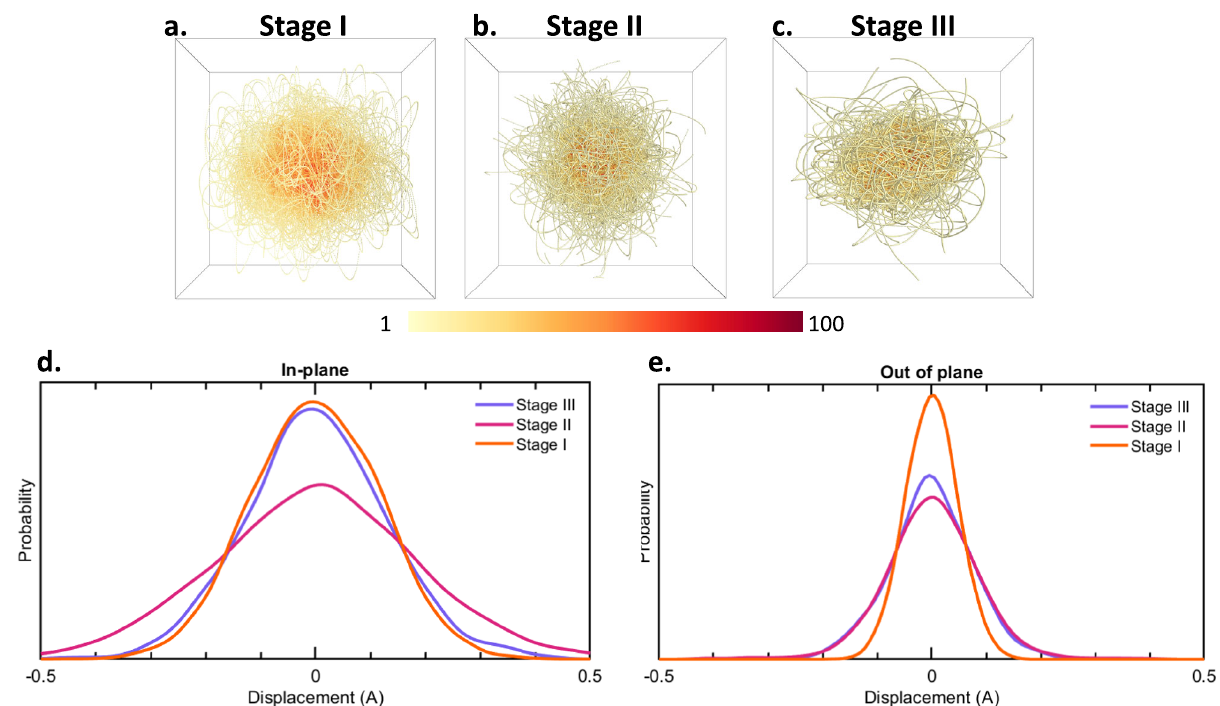
Fig. 2 | Structuralanalysis ofLi-GICs.a – c Liatom librationaldisplacement within the graphitic cage, in LiC 6 , LiC 12 , and LiC 18 respectively, showing the probability weight of lithium position within the graphitic cage. d In-plane projection of the Li